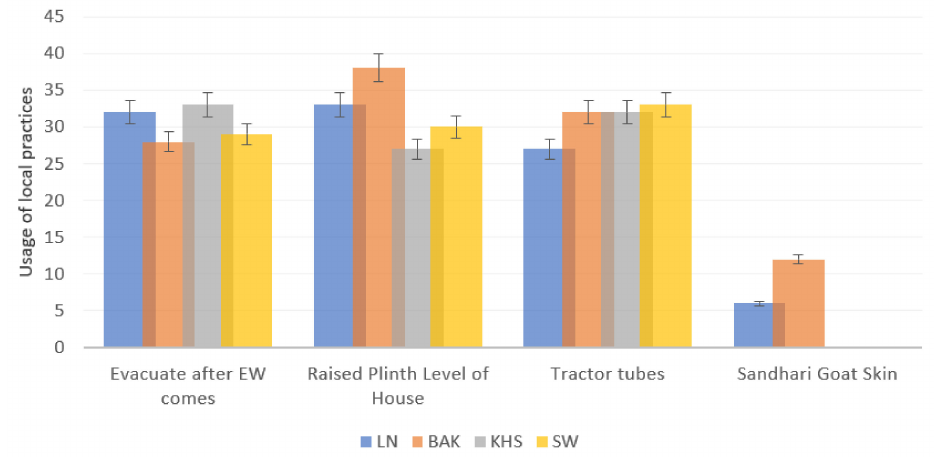
Figure 11. Local indigenous practices for flood risk management in affected union councils of district Layyah in 2010